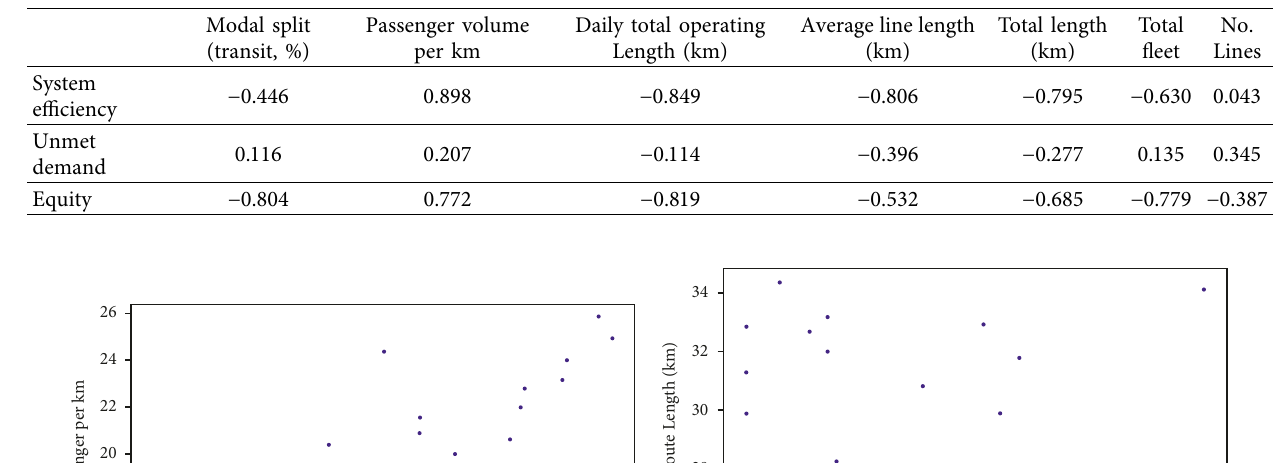
Figure 8: Pareto surface and pareto optimal. (a) Pareto surface between the three objectives. (b) Pareto optimal between system efficiency and equity. (c) Pareto optimal between system efficiency and unmet demand. (d) Pareto optimal between unmet demand and equity. Table 4: Results of spearman correlation analysis.